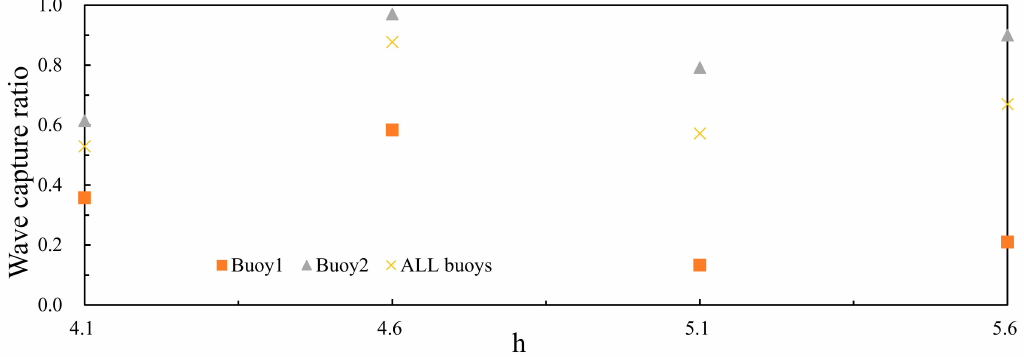
Figure 23. Curve of capture width ratio with